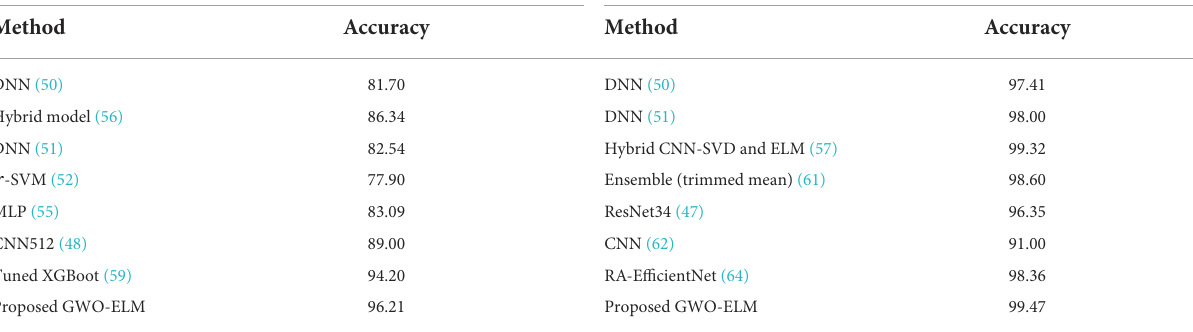
TABLE 10 The comparison of accuracy between the proposed GWO-ELM and other previous works. Accuracy results based on APTOS-2019 dataset with 5 classes